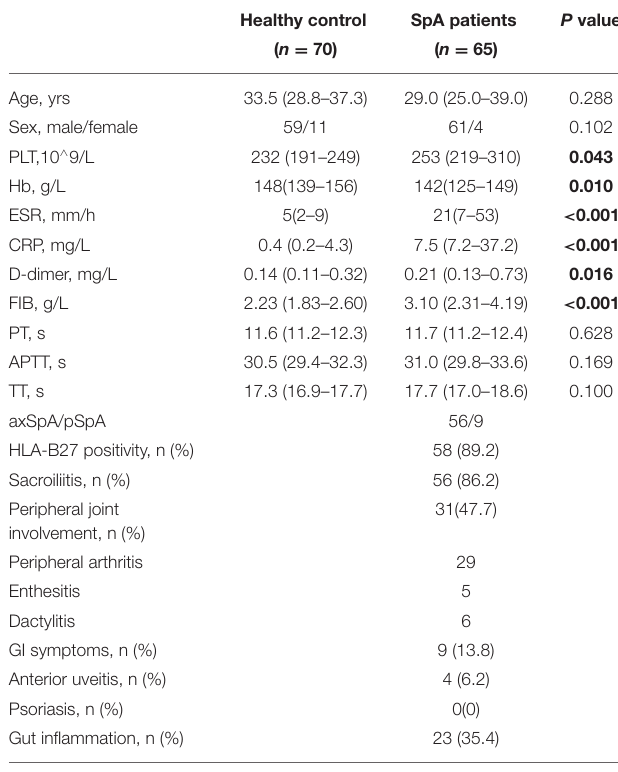
TABLE 1 | Demographic, laboratory, and clinical characteristics of the